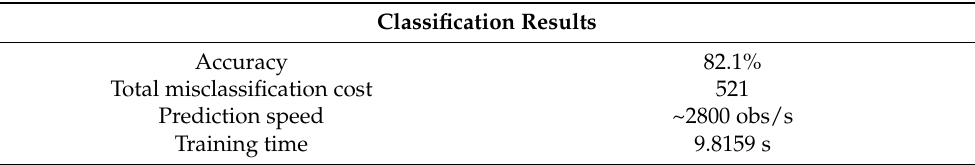
Figure 14. Classification results and confusion matrix for thick samples based on reflection mode. ( a ) Feature patterns of classification results of the cubic SVM model (observation 519 vs. feature 871). ( b ) Features patterns of classification results of the cubic SVM model (observation 1 vs. feature 317). ( c ) Confusion matrix. Table 14. Classification results for thick samples based on reflection